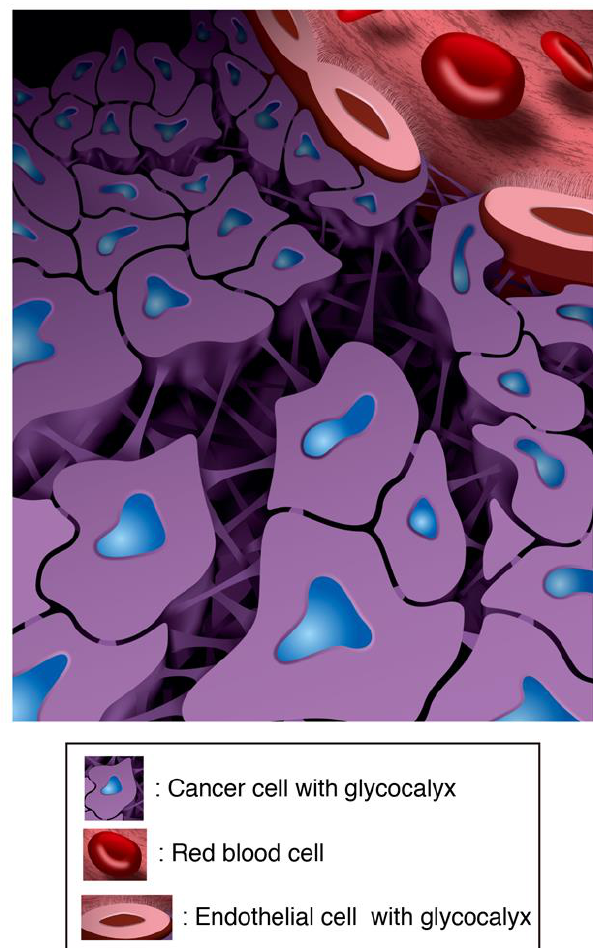
Figure 7. Diagram showing three-dimensional (3D) cancer infrastructure in human CRC.